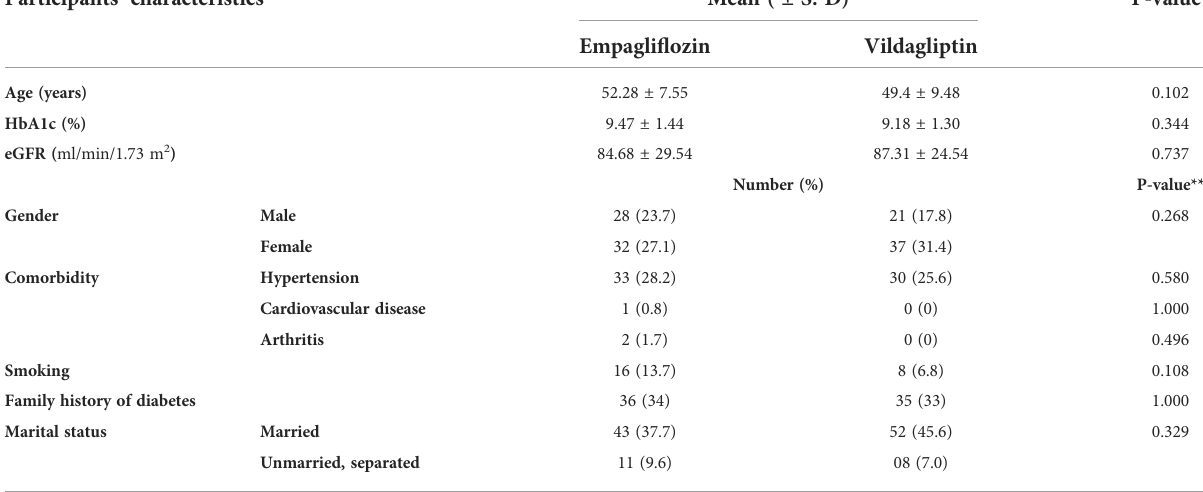
TABLE 1 Demographics of the study